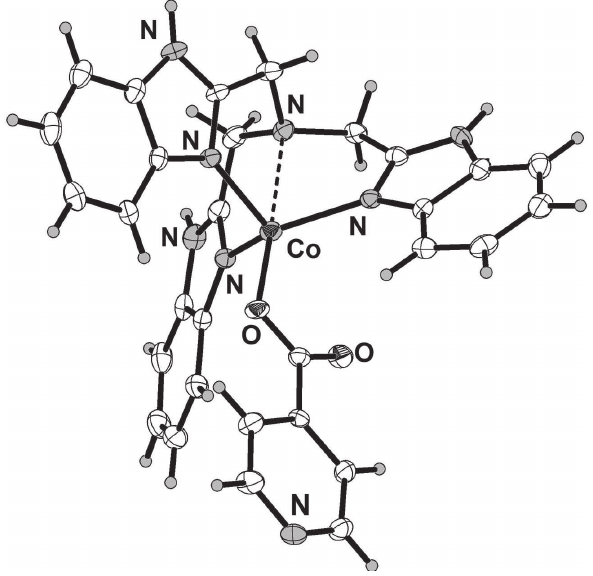
Table 1: Data collection and handling.